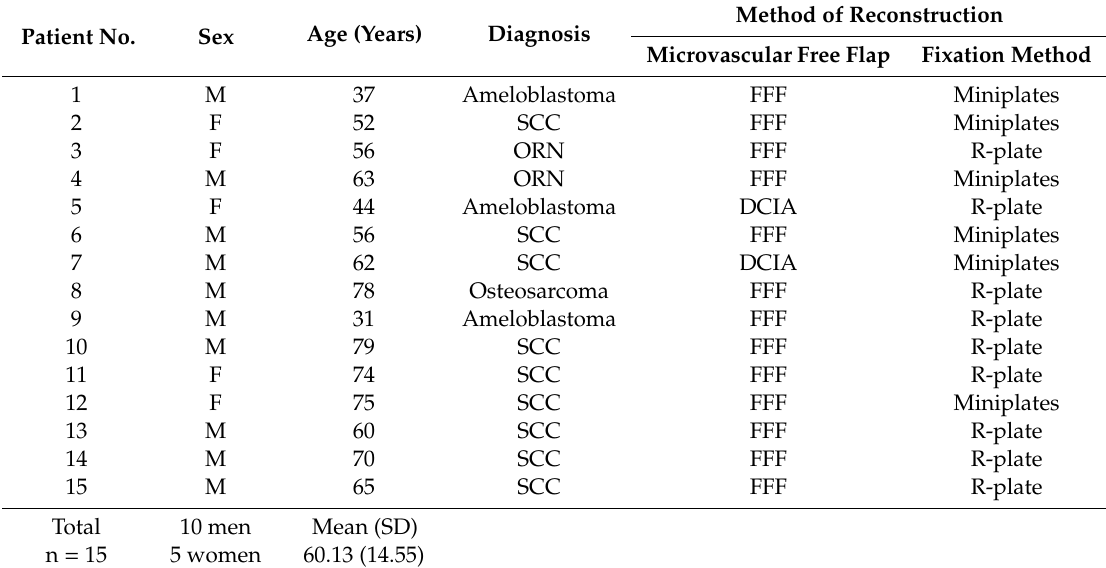
Table 1. Patient demographic and clinical